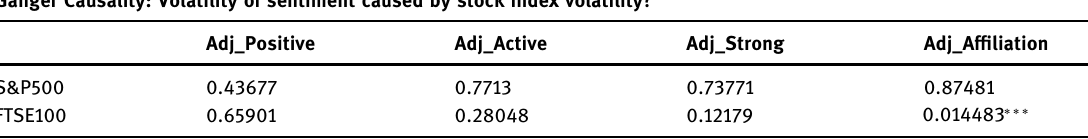
Table 8: F - statistics for the hypothesis H 0 : the asset return volatility does not Granger cause the sentiment volatility Ganger Causality: Volatility of sentiment caused by stock index